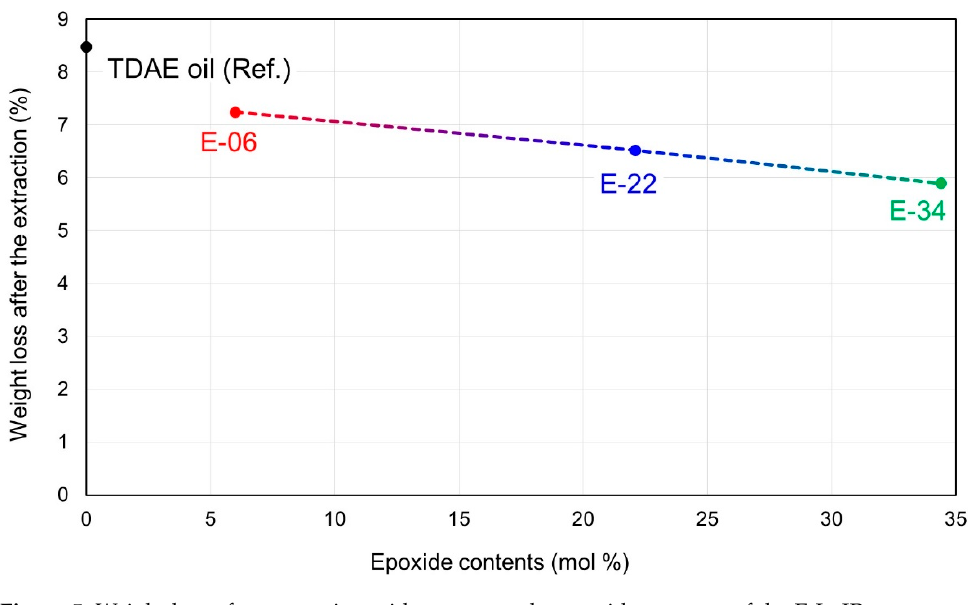
Figure 5. Weight loss after extraction with respect to the epoxide contents of the E-LqIRs. Table 6. Weight loss and crosslink densities of the vulcanizates (units: 10 − 5 mol/g).